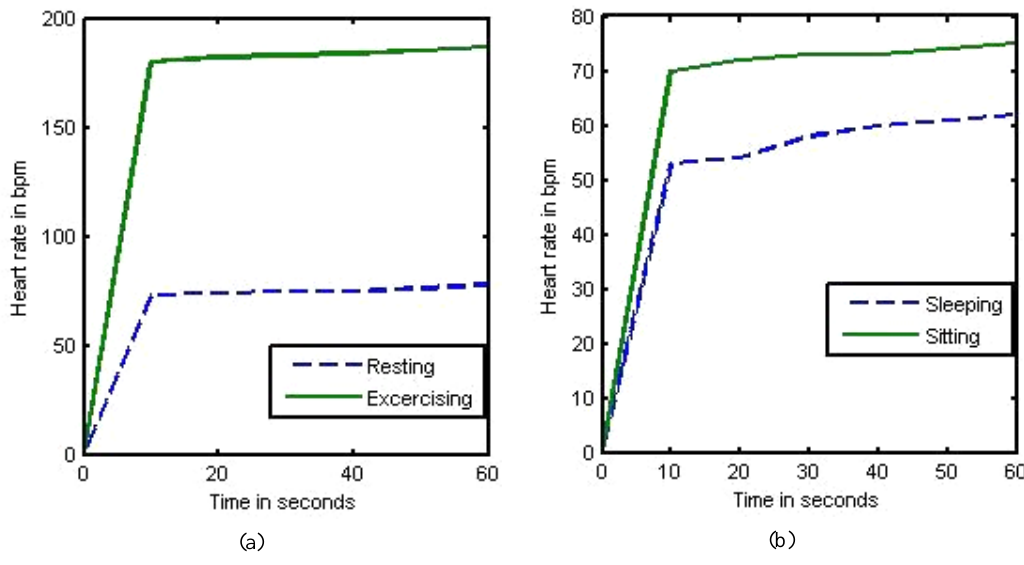
Figure 5. (a) Resting vs. exercising, and (b) sleeping vs. sitting